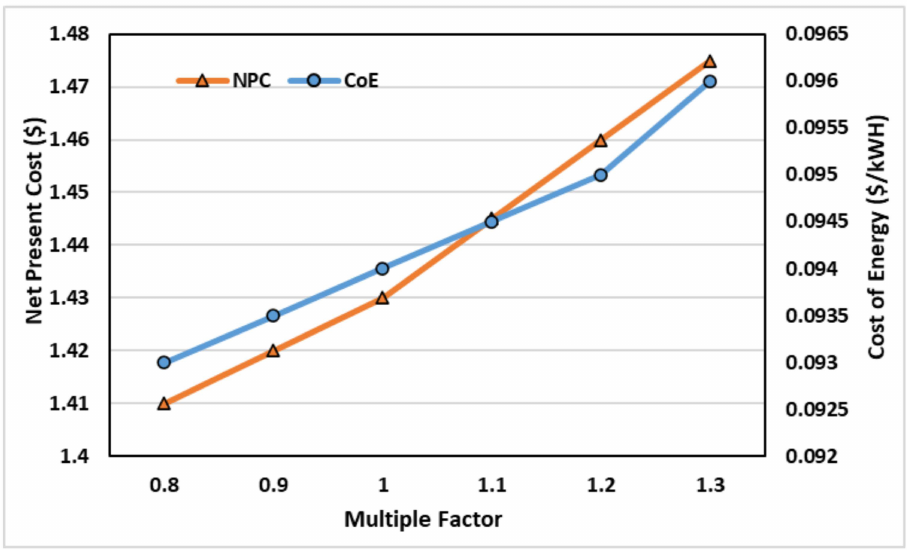
Figure 11. NPC and CoE of HRES with variation in PV-PCM